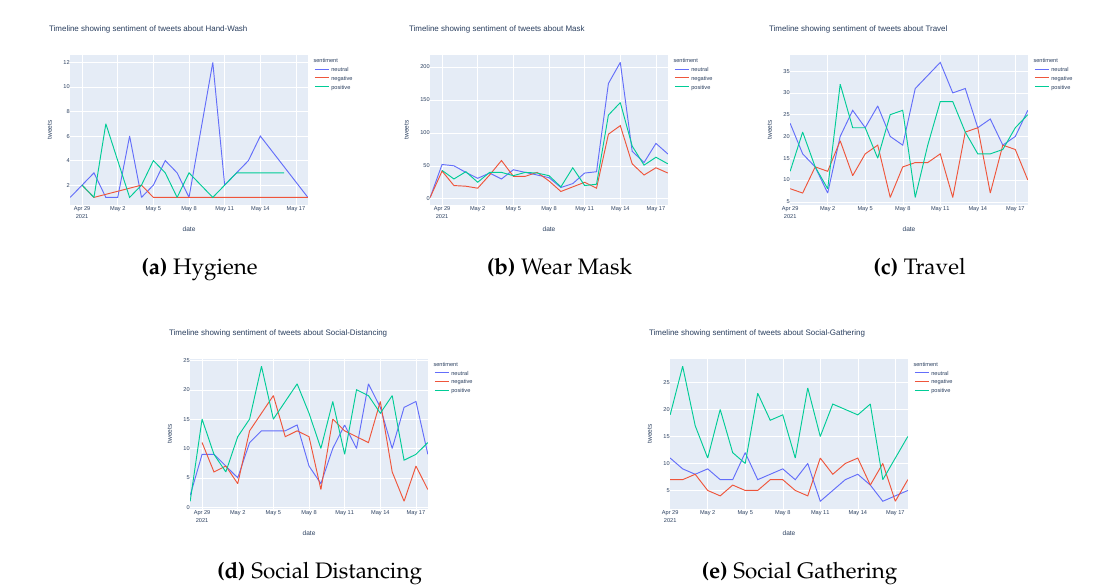
(e) Social Gathering Figure 7. Public Sentiment for Twitter Dataset 2 on Healthy Lifestyle with Timeline using TextBlob